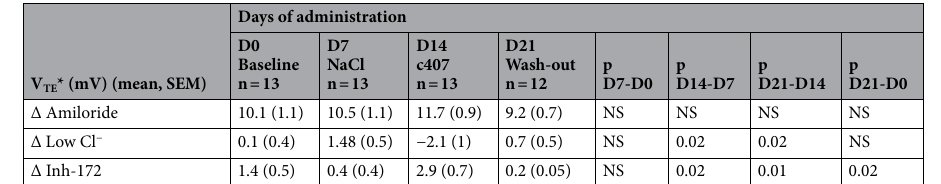
Table 1. Nasal potential difference in F508del Cftr tm1Eur mice after nasal application of c407 or vehicle. Univariate analysis by Repeated Measures ANOVA test. *V TE : Transepithelial Potential Difference.